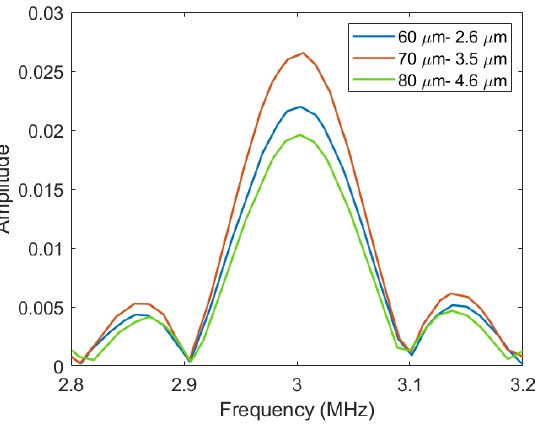
Figure 8. The fractional bandwidth of different membrane radius thickness combinations.